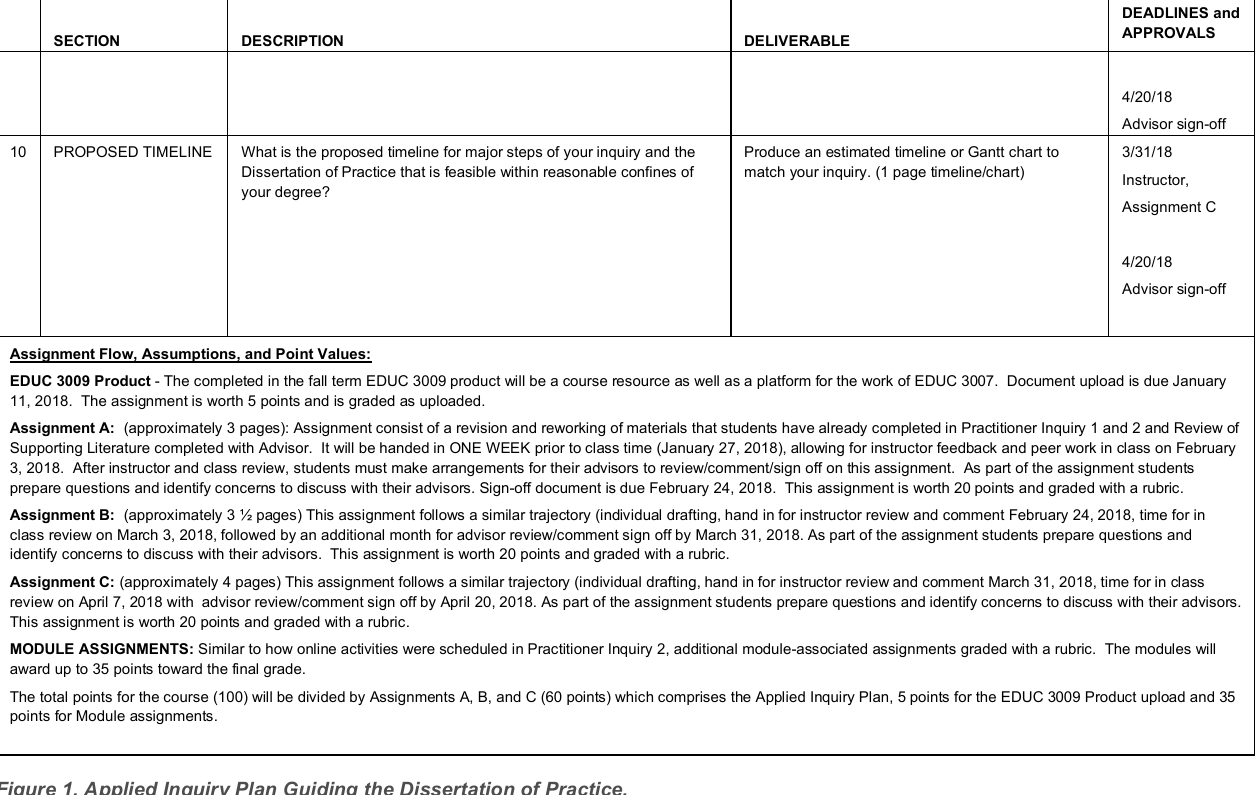
Figure 1. Applied Inquiry Plan Guiding the Dissertation of Practice.